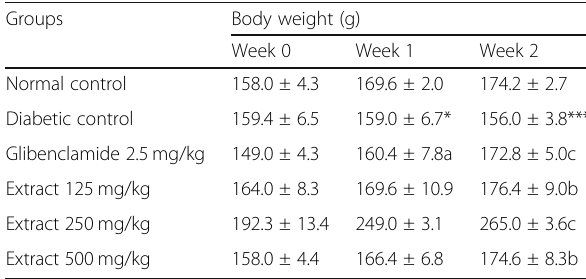
Table 1 Effect of Vitellaria paradoxa extract on the relative body weight in alloxan-induced diabetic